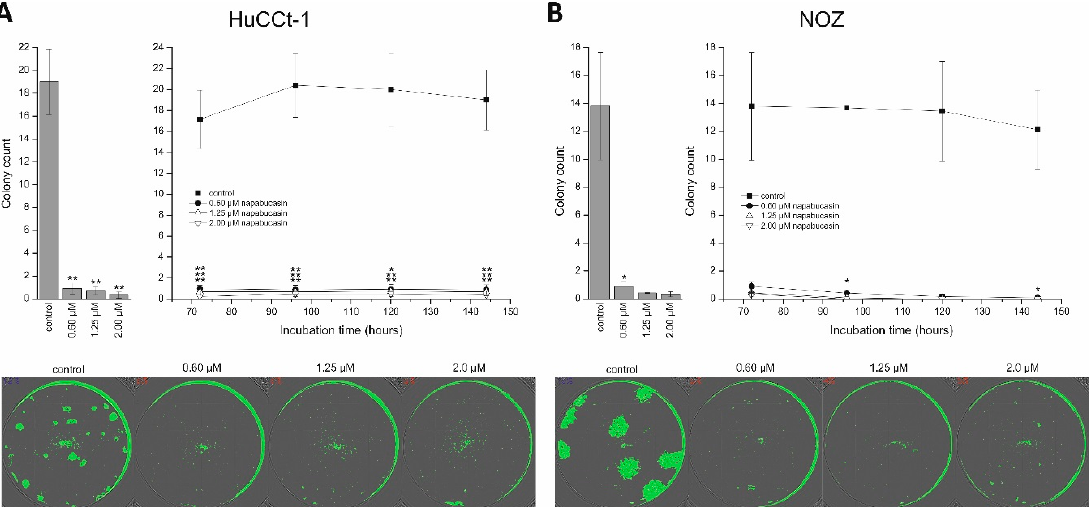
Figure 4. Napabucasin abolishes clonogenic growth in biliary tract cancer cells. ( A ) Quantification of clonogenic growth of HuCCt-1 cells after 144 h napabucasin incubation (left) and as a time-resolved analysis of the same wells (right). Exemplary confluence images after 144 h of napabucasin are shown in the lower part. ( B ) Quantification of clonogenic growth of NOZ cells after 144 h napabucasin incubation (left) and as a time-resolved analysis of the same wells (right). Exemplary confluence images after 144 h of napabucasin are shown in the lower part. Data are presented as mean value ± SEM related to untreated control cells of at least three individual biological replicates. * indicates significant ( p < 0.05) and ** highly significant ( p < 0.01) results.